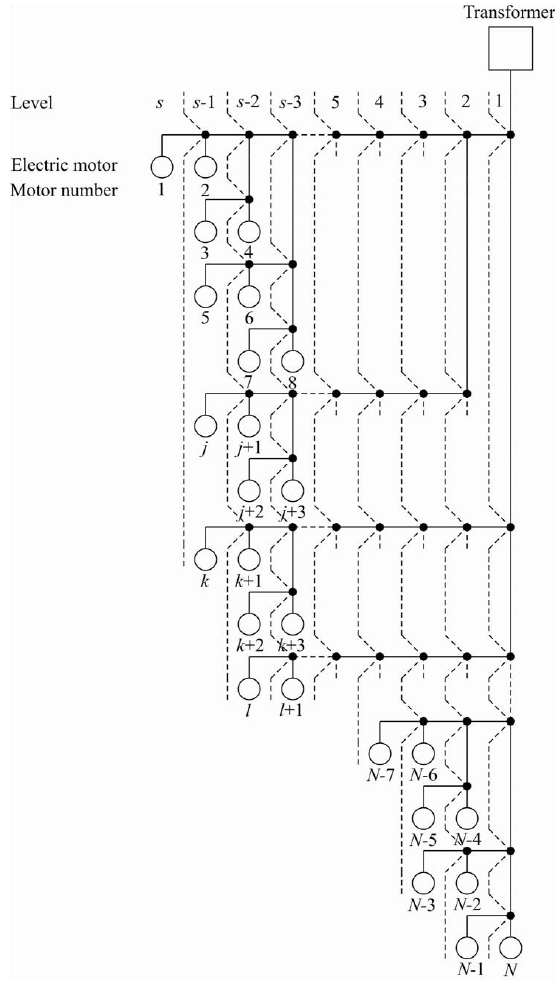
Figure 6. Electric power supply network of an arbitrary structure with an electric